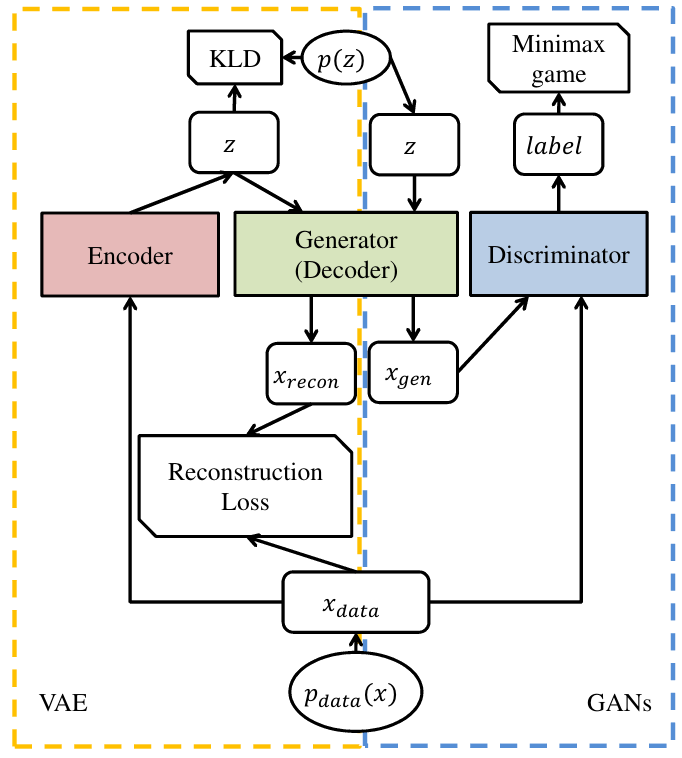
Figure 3. The architecture of the proposed